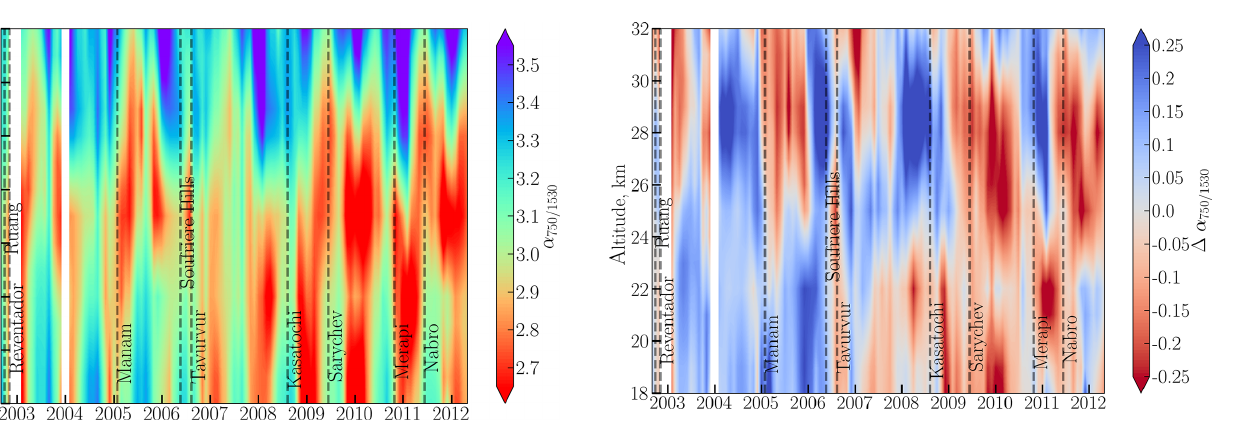
Figure 9. Monthly zonal mean values of the Ångström exponents ( α 750 / 1530 ) derived from SCIAMACHY limb data in the tropics (20 ◦ N–20 ◦ S).